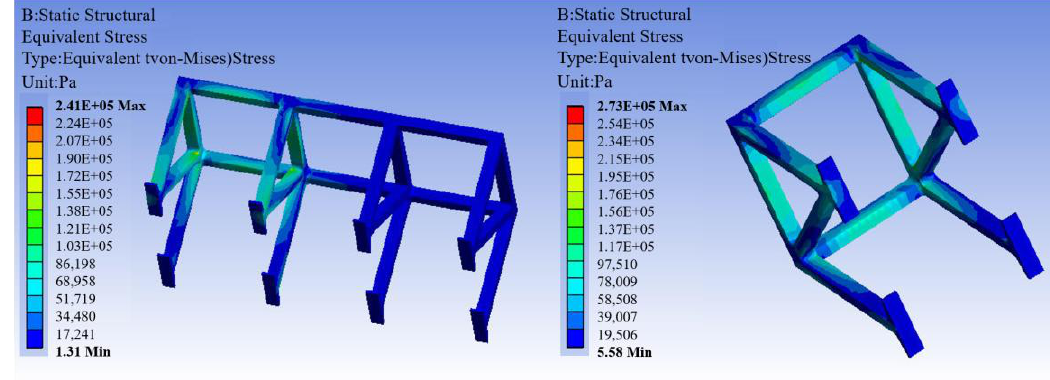
Figure 26. Stress analysis for comparison of the support parts between redesign and the traditional